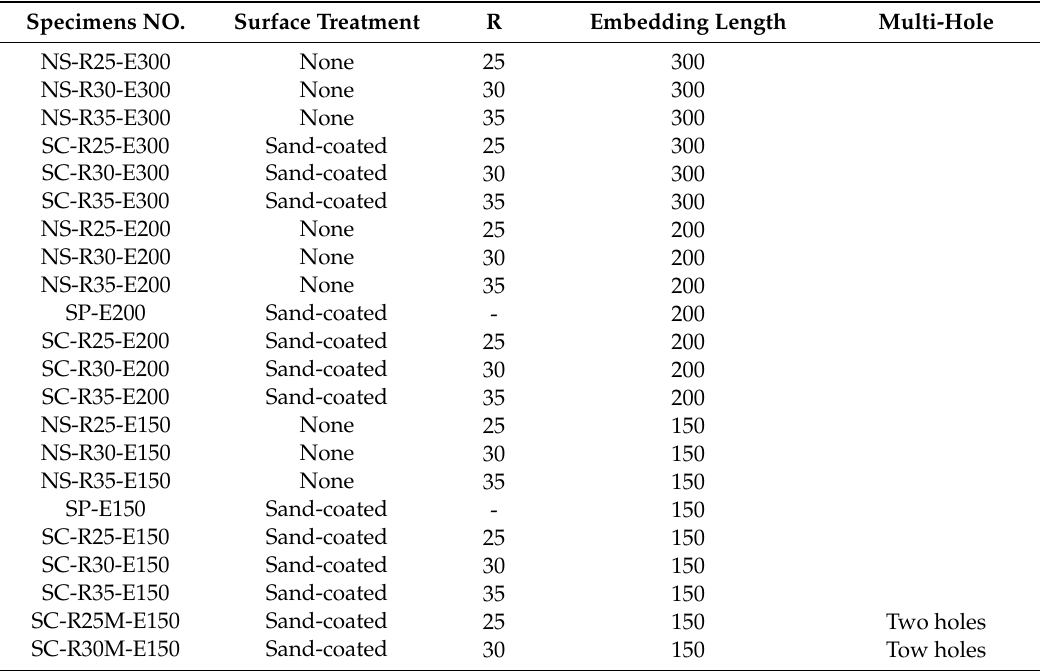
Table 5. Dimensions of parametric specimens (unit: mm).